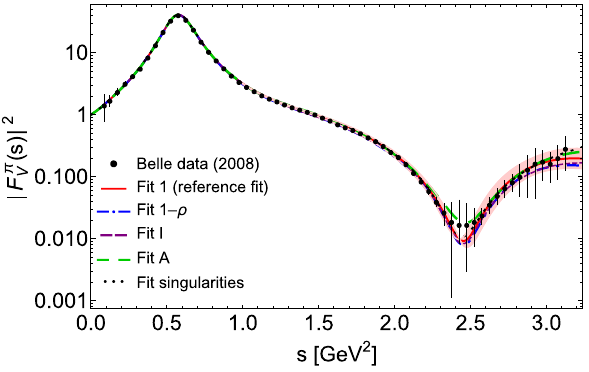
Fig. 5 Belle measurement of the absolute value squared of the pion vectorformfactor(blackfilledcircles)[31]ascomparedtoourreference fit in Table1, Fit 1 (solid red curve), and to our Fit 1- ρ at the matching point of 0.85 GeV (dot-dashed blue curve), Fit I (short dashed purple curve), Fit A (long dashed green curve) and with the fit that avoids singularities (dotted black curve). See main text for details